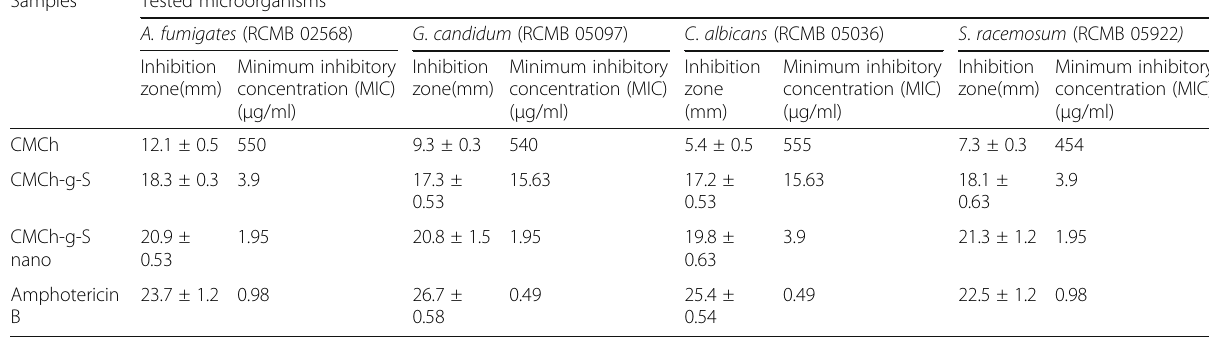
Table 2 Antifungal activity of CMCh, CMCh-g-S and CMCh-g-S nano Samples Tested